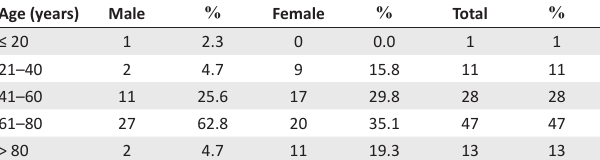
TABLE 2: Age and gender distribution of hospitalised patients who died due to COVID-19.